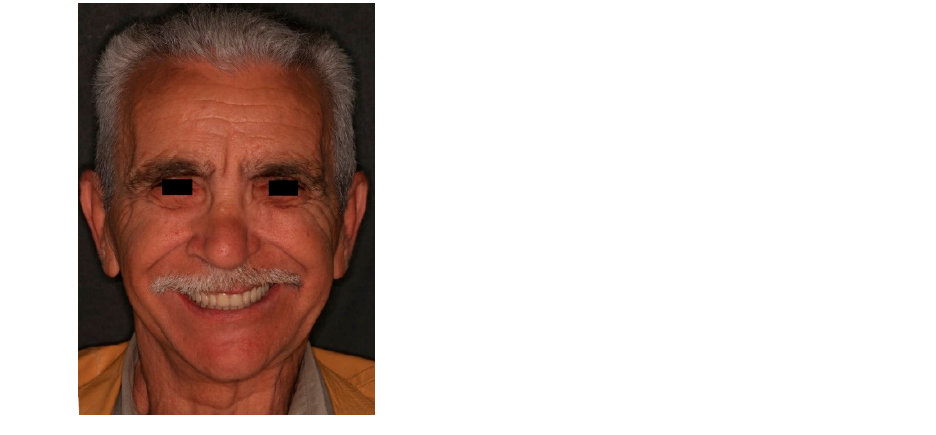
Figure 7. Definitive maxillary and mandibular prostheses delivered to the patient.